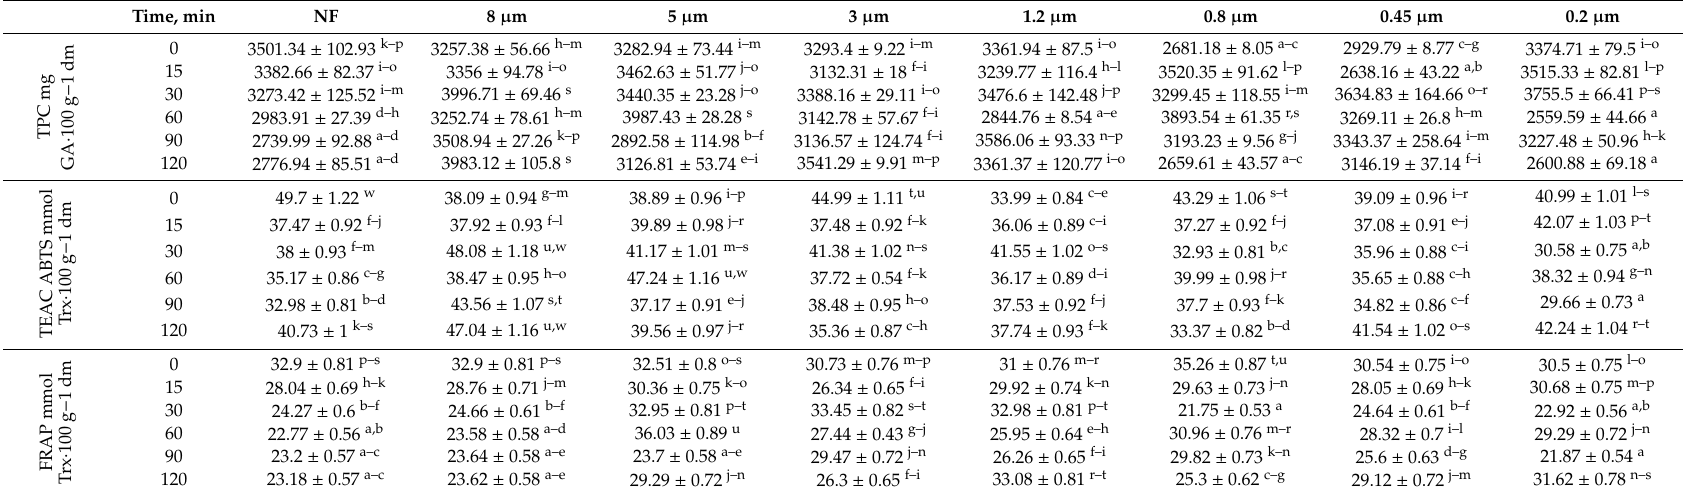
Table 4. Total polyphenolic content (TPC) and antioxidant capacity measured by TEAC ABTS and FRAP of filtrated and non-filtrated osmotic